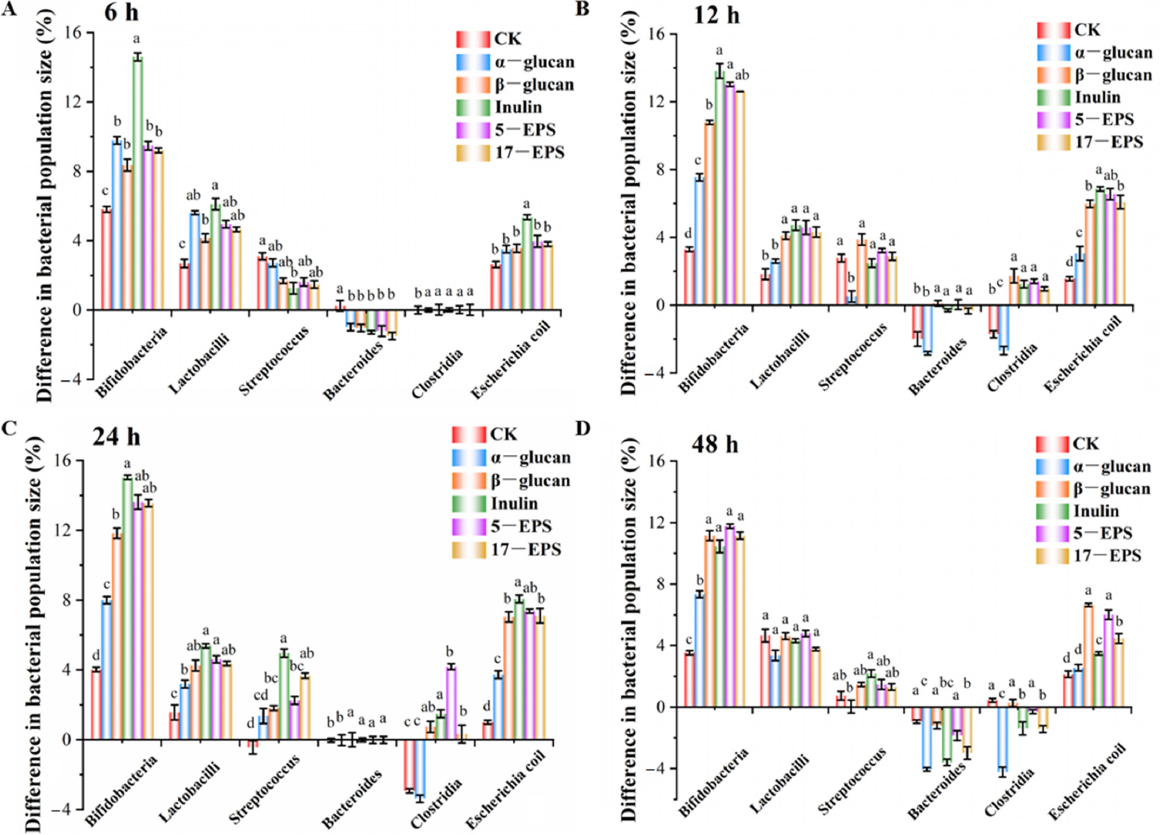
Figure 3. Differences between the sizes of bacterial populations as measured by the total numbers of bacteria that were counted at 6 h ( A ), 12 h ( B ), 24 h ( C ), and 48 h ( D ) using various purified EPS fractions as substrate. The error bars show the standard deviations. Statistically significant differ- ences ( p < 0.05) were denoted by corresponding lowercase letters (a, b, c and d) using different polysaccharides as a substrate at each time